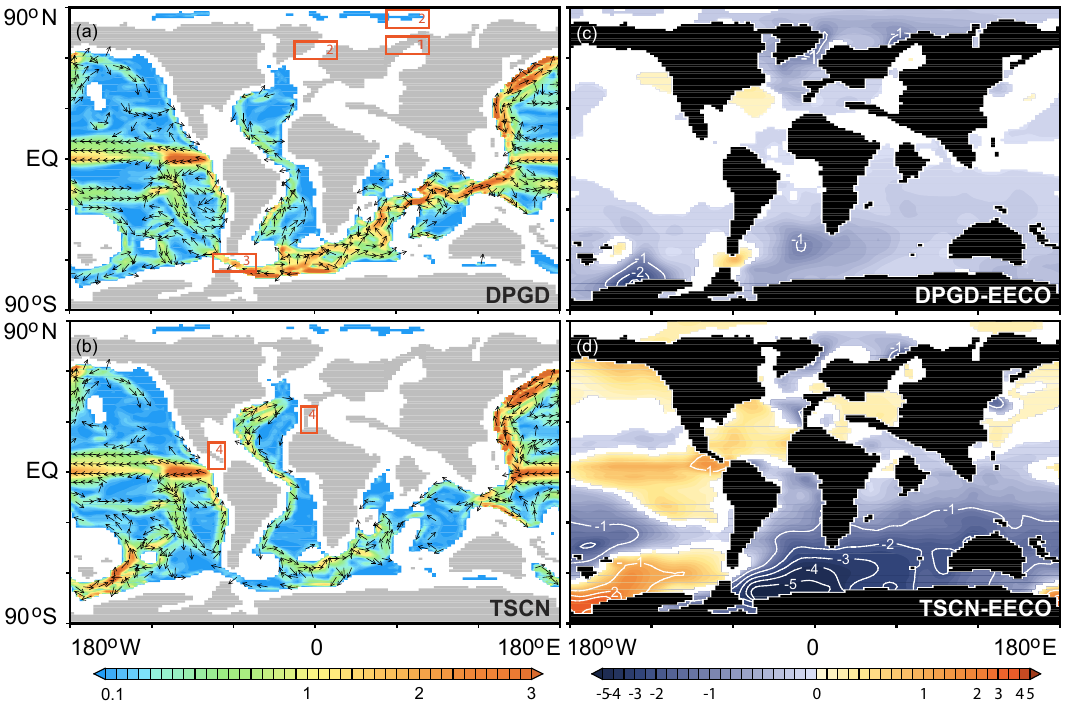
Figure 3. Transition of ocean circulation from a SODW-dominated to a NADW-dominated mode and it impact on SST. Deep ocean currents (cm/s) at 2500m for experiments (a) DPGD and (b) TSCN. Geographic distributions of SST changes ( o C) in the DPGD (c) and the TSCN (d) experiments, compared to the control experiment (EECO). Arrows show flow directions, and colour scales show current speed. Changes in seaways are highlighted by red rectangles: 1), closing of the West Siberian Seaway (WSSC); 2), deepening of the Arctic/Arctic-Atlantic Seaway (AASD); 3), deepening of the Drake Passage Gateway (DPGD); 4), constriction of the tropical Atlantic seaways (TSCN), with a fully closed Tethys seaway and narrow Central American seaway. The statistical signifcance has been tested with the t-test, based on annual mean SST time series for each point. Only SST changes with confidence levels greater than 95% are illustrated here.